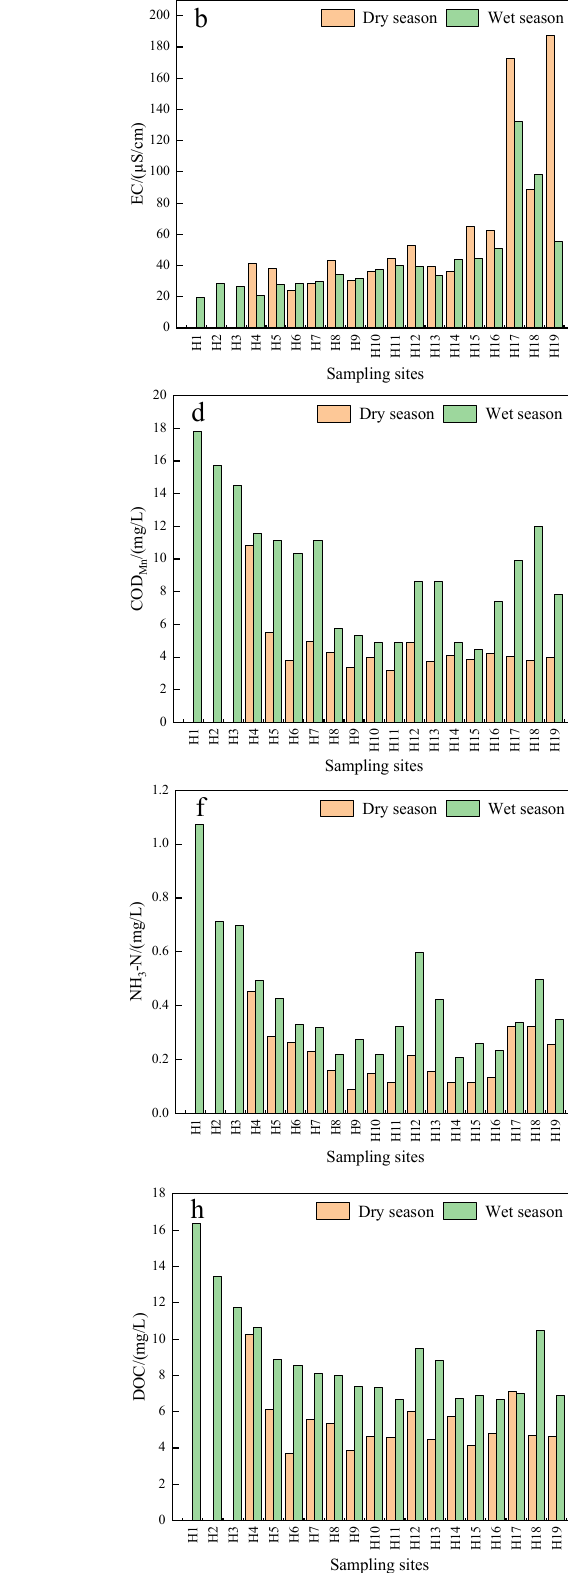
Figure 2. Seasonal and spatial variations in water quality parameters. ( a ) pH; ( b ) EC; ( c ) DO; ( d ) COD Mn ; ( e ) BOD 5 ; ( f ) NH 3 -N; ( g ) TP; ( h ) DOC. On the whole, the pH values during the dry and wet seasons were around 7.0. EC and DO concentrations during the dry season were higher than those during the wet sea- son, while COD Mn , BOD 5 , NH 3 -N, TP, and DOC concentrations during the dry season were lower than those during the wet season. The results showed that water quality parameters in the HRB displayed distinct seasonal variations. In addition, COD Mn , BOD 5 , NH 3 -N, and DOC concentrations exhibited a fluctuating decreasing trend from the upstream to the downstream, indicating that headwaters in the HRB presented a higher background value. The leaching of humic substances (e.g., fresh plant lier and soils) in forests could be an important allochthonous source of nutrients and DOC in river ecosystems [36,37]. Significantly, COD Mn , BOD 5 , NH 3 -N, DOC, and TP concentrations in the downstream in- creased compared with those in the midstream, particularly the concentration of TP (Fig- ure 2g). Furthermore, EC exhibited an increasing trend from the upstream to the down- stream (Figure 2b). This could be aributed to agricultural activities in the lower HRB. The upper and middle reaches are mountainous, whereas the lower reaches are low, hilly areas with a small amount of cultivated land. DOM in agricultural soils can be transported into the HRB through the leaching process. 3.2. UV-Visible Spectra Figure 3 shows several UV-visible spectral parameters variations from the upstream to the downstream. UV 254 indicates the relative content of natural humic-like macromo- lecular organic maer and aromatic organic maer containing C=C and C=O [38]. UV 254 values during the wet season were higher than those during the dry season, which sug- gests that the content of natural macromolecular organic maer during the wet season was higher than that during the dry season. Moreover, UV 254 values exhibited a decreasing trend from the upstream to the downstream, indicating that headwaters contained more natural macromolecular organic maer. SUVA 254 was positively correlated with the aro- matic carbon content in DOM [23]. The SUVA 254 values during the dry and wet seasons were above 3 L·mg·m −1 , indicating that DOM in the HRB predominantly consisted of aro- matic and high-molecular-weight natural organic maer [39]. Significantly, the SUVA 254 values during the wet season were much higher than those during the dry season, which showed that DOM during the wet season contained more aromatic and high-molecular- weight natural organic maer. We observed that S 275–295 < S 350–400 at each site in this study, suggesting that DOM in the HRB was dominated by terrestrially derived substances. Helms et al. [25] illustrated that lower S R values were indicative of a growth in DOM mo- lecular weight. The S R values during the dry season were higher than those during the wet season, indicating that the DOM during the wet season had a higher molecular weight than that during the dry season. The results were mainly aributed to the introduction of natural organic maer into the HRB through rainfall and runoff during the wet season.